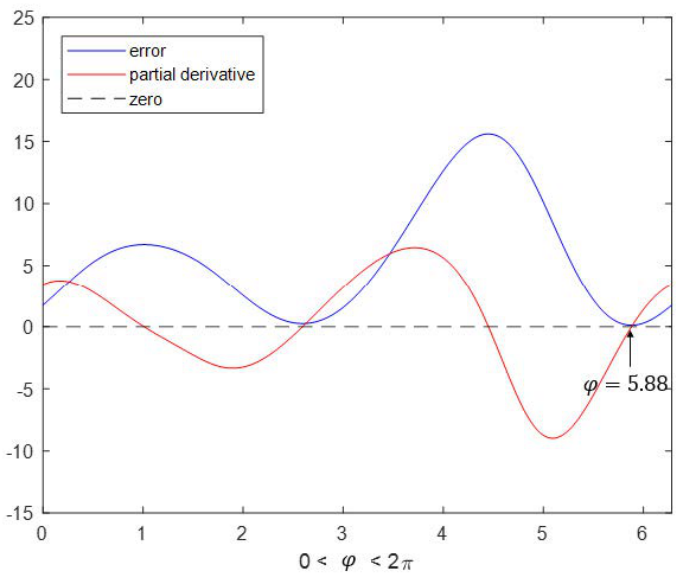
Figure 4. Error function for a point i evaluated at [0,2 π ).